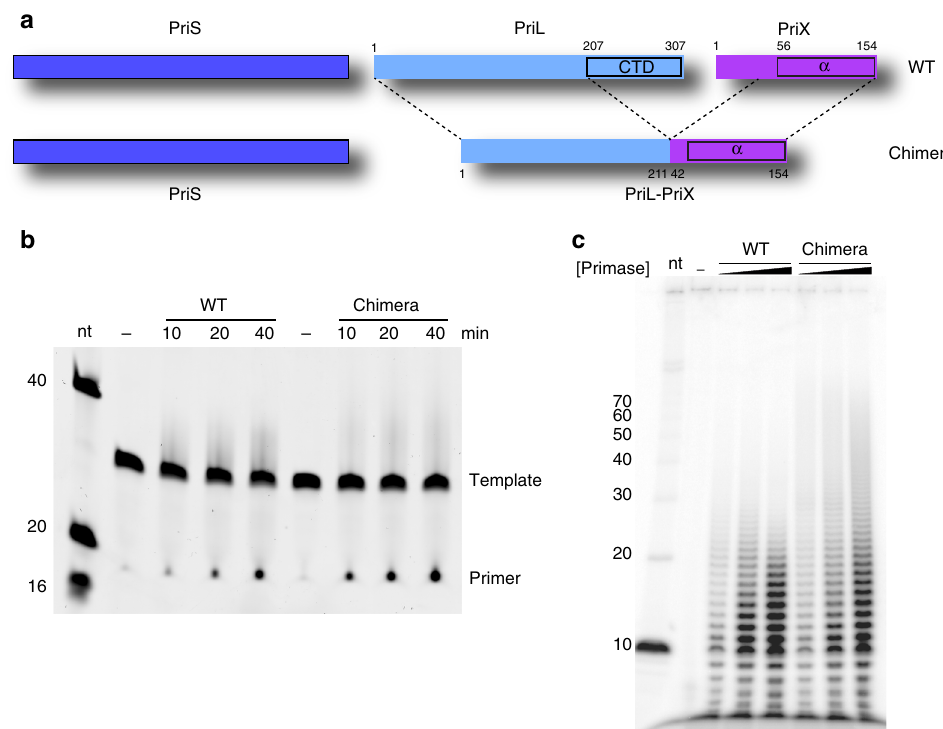
Fig. 4 Design and functional characterization of Chimera. a Subunit structure of wild-type PriSLX and Chimera. In the second subunit of Chimera, amino acids 1 to 211 of PriL are fused to amino acids 42 to 154 of PriX. b Primer synthesis assay on mixed-sequence ssDNA 30mer with fi xed concentration of wild-type and mutant primase, at 10 ′ , 20 ′ and 40 ′ time points. The reaction products were separated by denaturing PAGE, stained with SYBR Gold and detected by phosphorimaging. c Primer synthesis assay on poly(dT) ssDNA with increasing concentrations (125 nM, 250 nM, and 500 nM) of wild-type PriSLX and Chimera. The reaction products were separated by PAGE under denaturing conditions and detected by phosphorimaging of the incorporated 32 P- α fi rst phosphodiester bond between two nucleotides is the critical